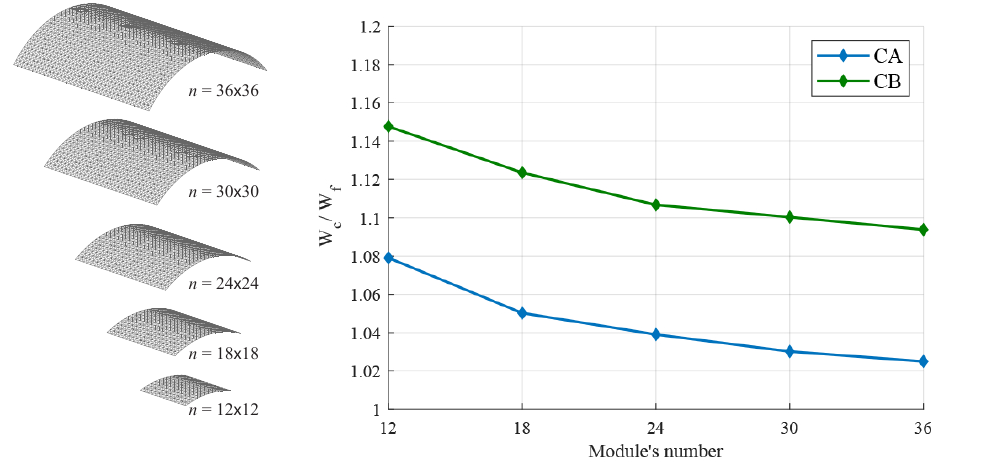
Figure 14. Percent error of CA and CB from the fine model with respect to modules’